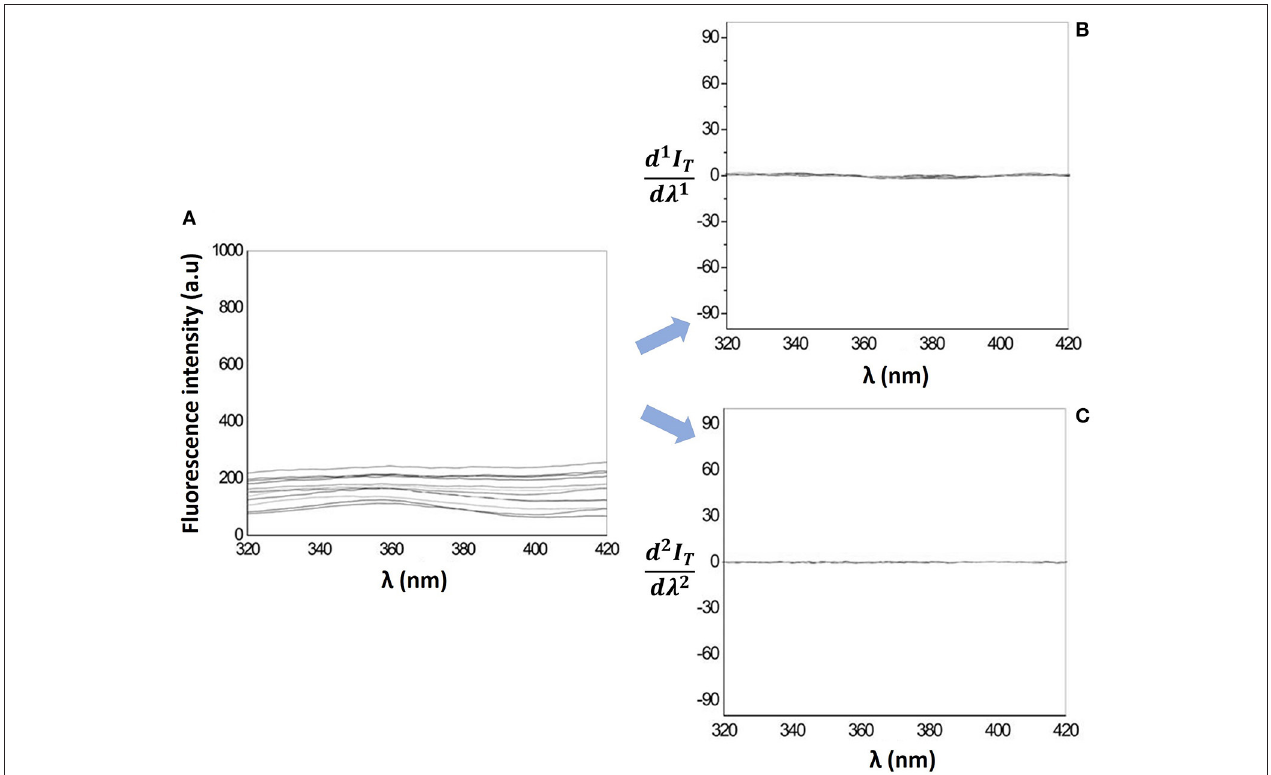
FIGURE 5 | (A) Fluorescence emission spectra and its first derivative spectra (B) and second derivative spectra (C) for increasing concentrations of MLVs of EPC (25–300 µ M) in Hepes buffer, pH = 7.4 and I =